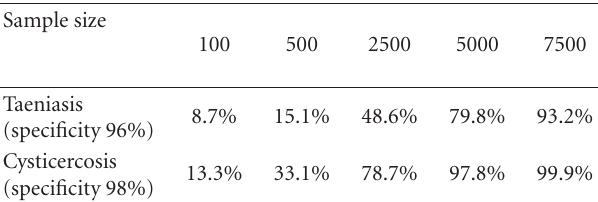
Table 2: Probability of declaring a region is disease-free given that the region has true zero prevalence; a high value of the probability is desirable. Sensitivity is assumed equal to